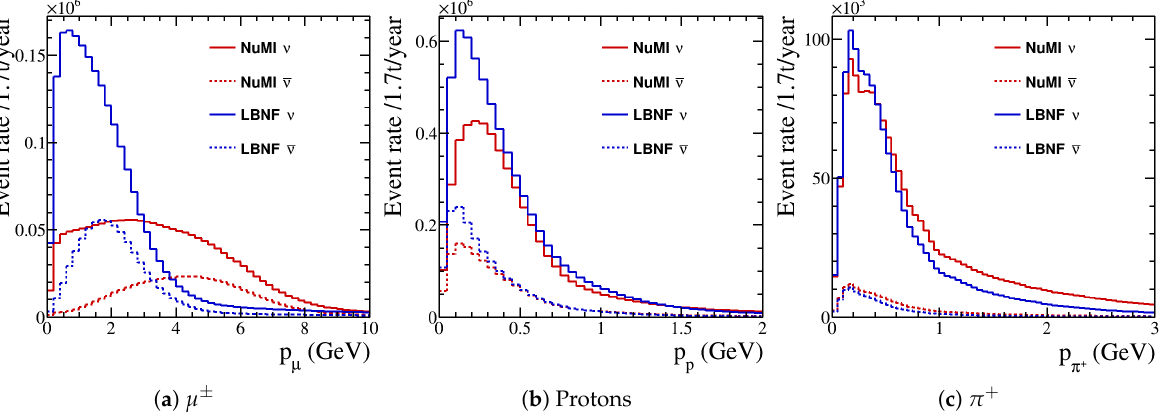
Figure 22. The yearly rates of various particles produced at the primary vertex, as a function of their momentum, as expected in the the demonstrator’s 1.7t LAr mass for the NuMI ME and LBNF fluxes, produced using GENIE v2.12.10 [71]. Note that every relevant particle from each event is